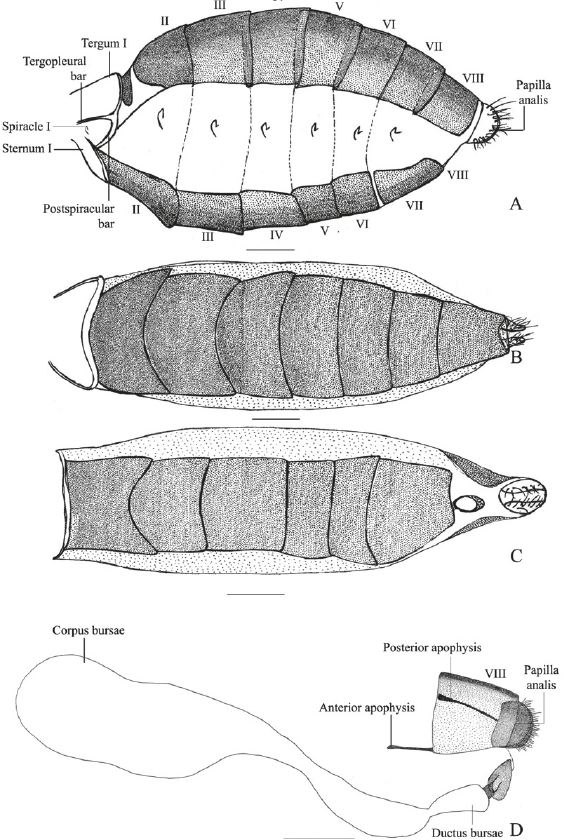
Figure 11. Male genitalia of Junonia almana (Linnaeus, 1758) A – B - abdomen (dorsal and ventral view, respectively); C - male genitalia (lateral view); D - uncus (dorsal view); E - right valva (inner view); F – H - aedeagus (dorsal, ventral and lateral view respectively). Scale bar 1mm.